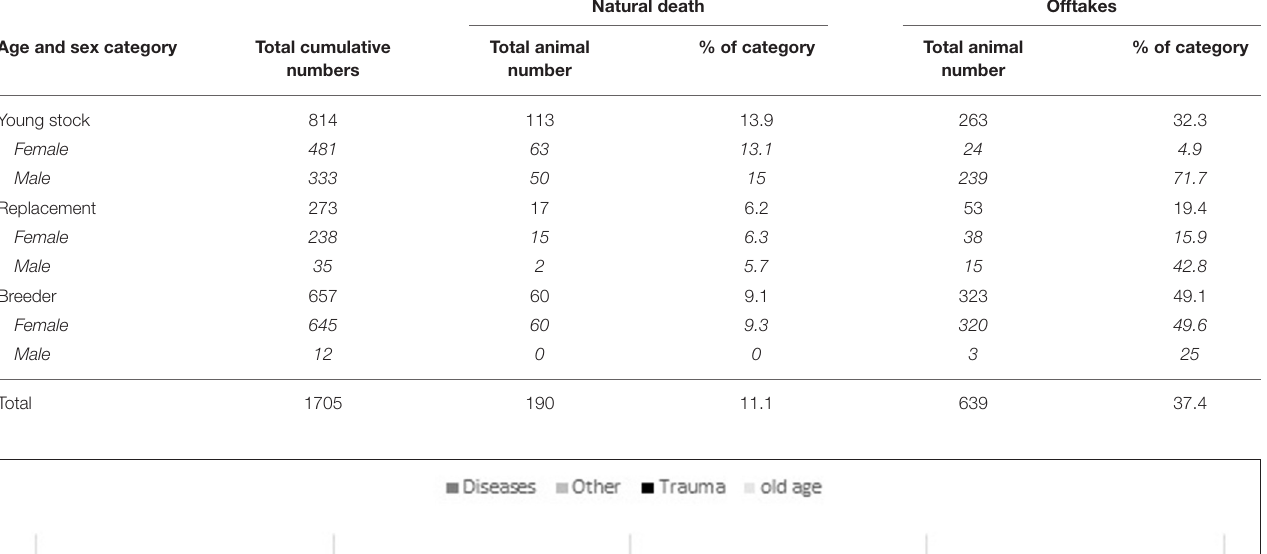
TABLE 2 | Mortality and offtake numbers by age and sex during the entire study period.